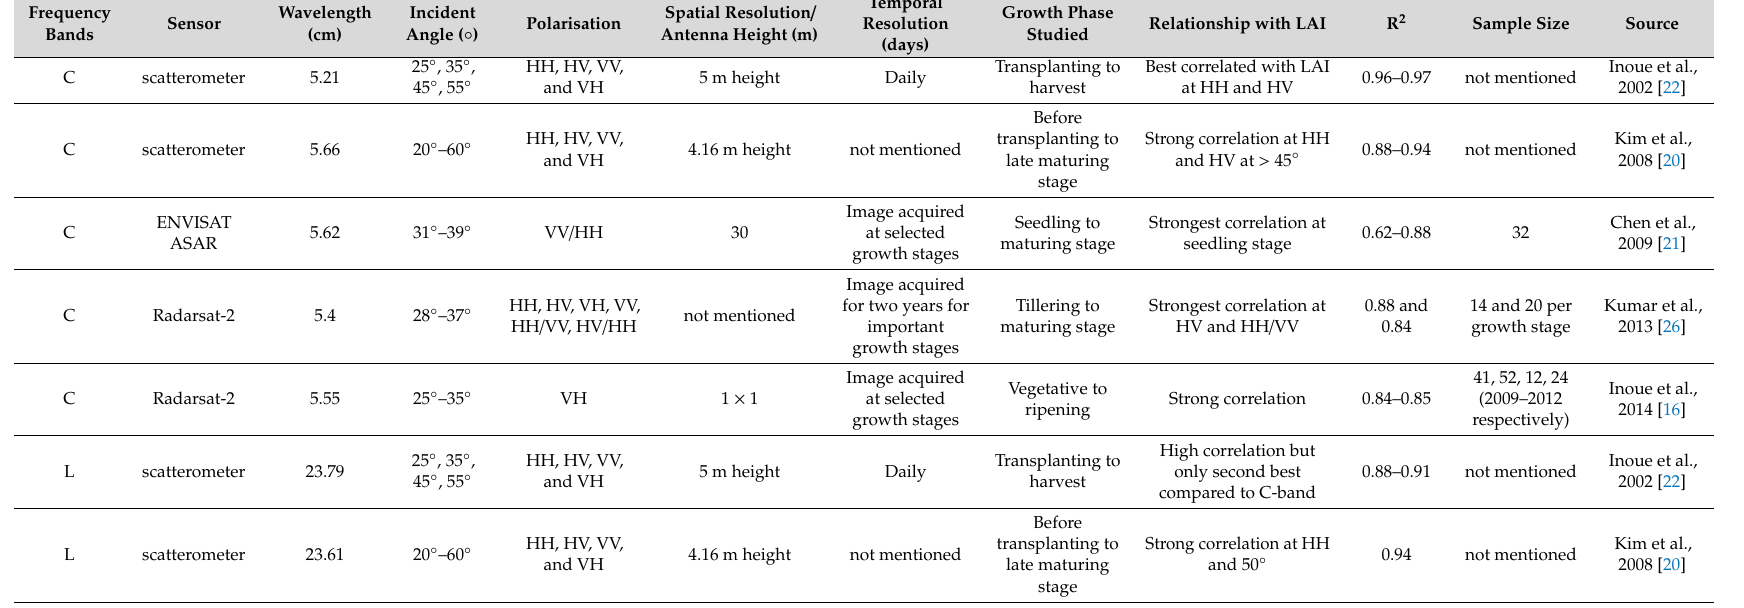
Table 2. Summary of studies over the years on the relationship of rice crop’s LAI with C and L-band backscattering intensity ( σ ◦